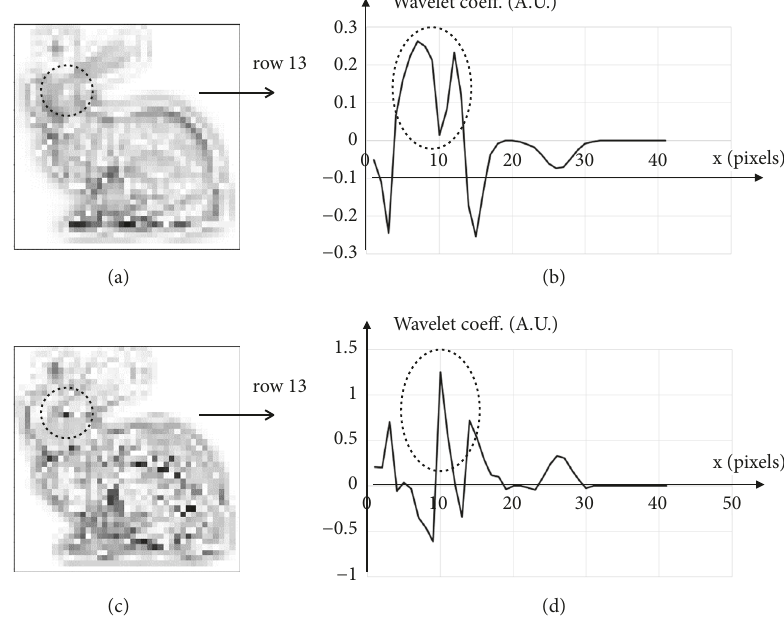
Figure 11: Wavelet coefficients in 2 nd plane for source and normalized images, row 13 on the right. The layout is the same as in Figure 6.